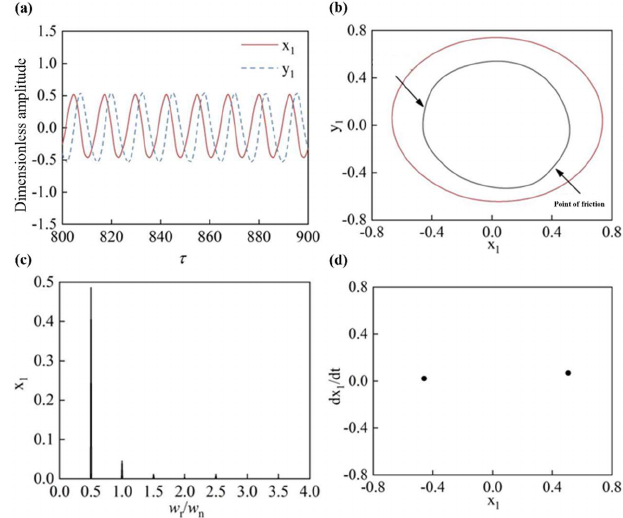
Figure 7. Rotor dynamic response under rub-impact: ( a ) time domain curve of impeller displacement change; ( b ) impeller axis locus; ( c ) frequency spectrum of the impeller; ( d ) impeller poincare drawing.